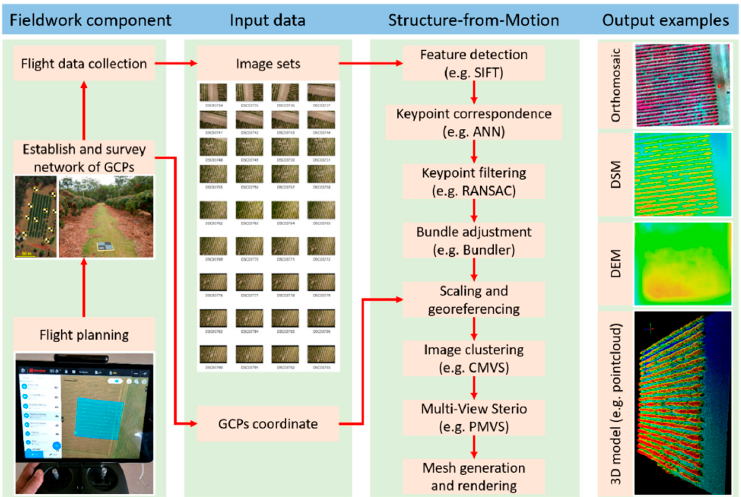
Figure 5. A typical workflow of structure-from-motion (SfM) to produce georeferenced products from UAS-based image sets and ground control points (adapted from [166,167]). SIFT = scale-invariant feature transform; ANN = approximate nearest neighbour; RANSAC = random sample consensus; CMVS = clustering views for multi-view stereo; PMVS = patch-based multi-view stereo; GCP = ground control